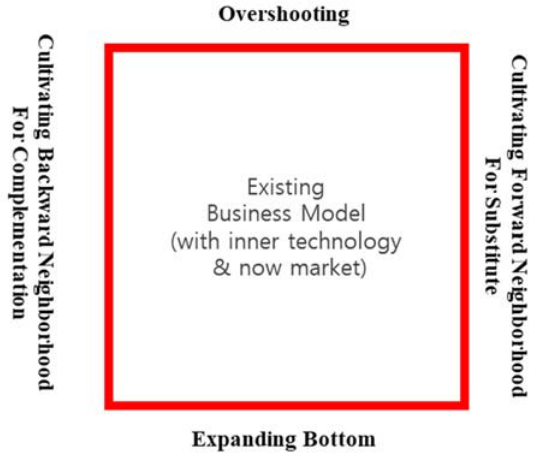
Figure 1. Research Framework I: rectangular compass concept building for business model innovation.